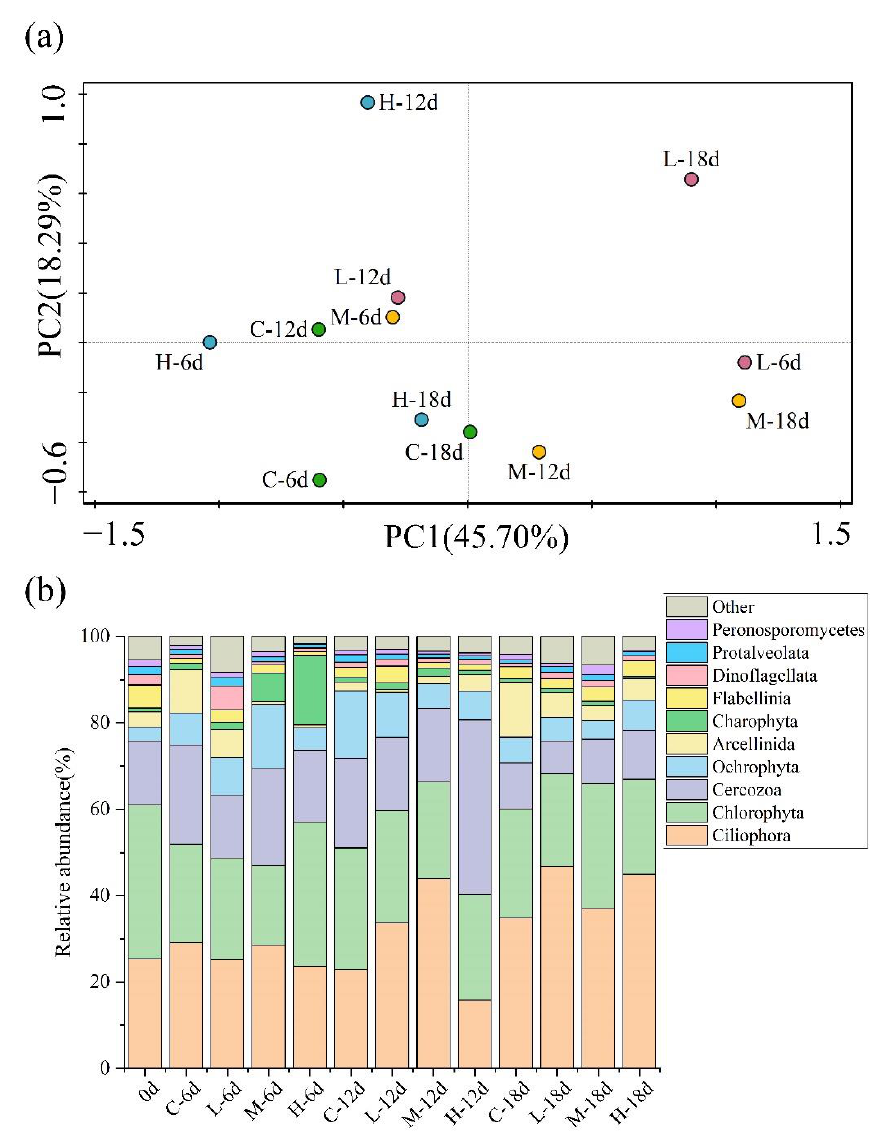
Figure 4. ( a ) PCA plot of eukaryotic communities at class level under different paroxetine-treated groups on day 6, day 12, and day 18. ( b ) Relative abundances of the eukaryotic communities over different time periods (at order level). C: the sediment with no paroxetine added ; L: 10 μg/L paroxetine; M: 100 μg/L paroxetine; H: 1000 μg/L paroxetine.